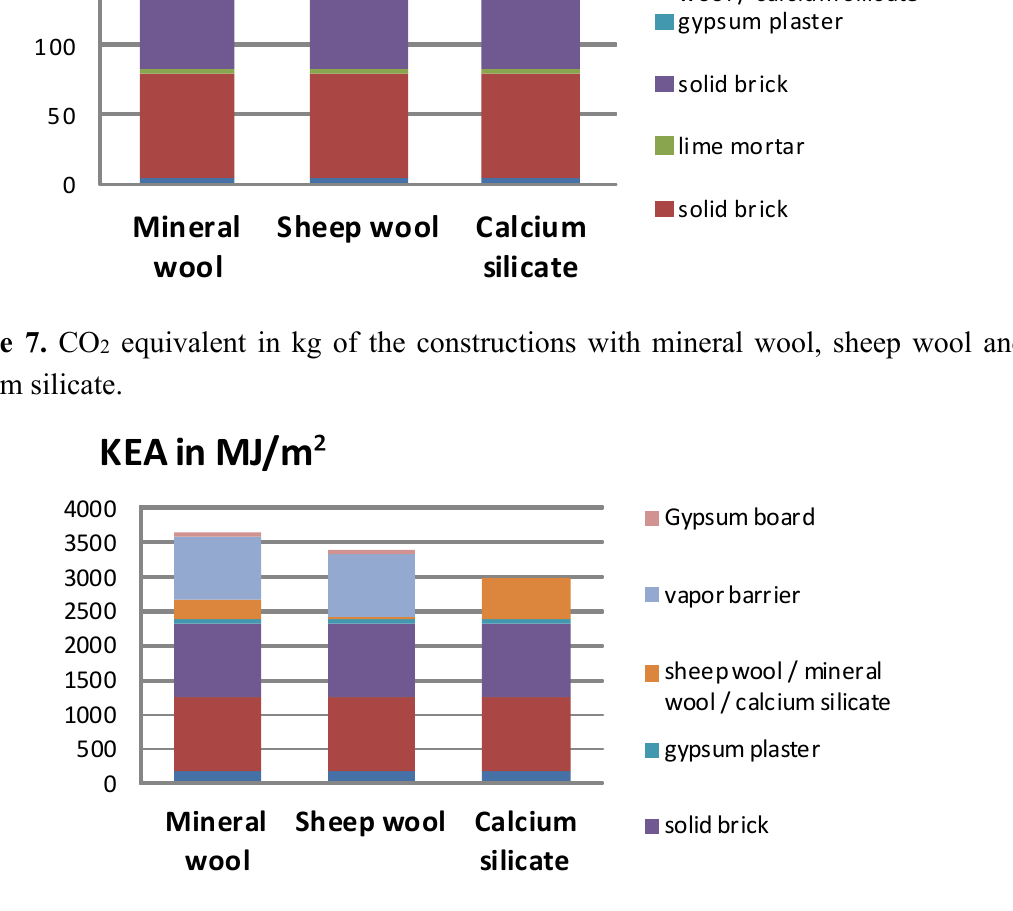
Figure 8. Cumulative energy demand of the constructions with mineral wool, sheep wool and calcium